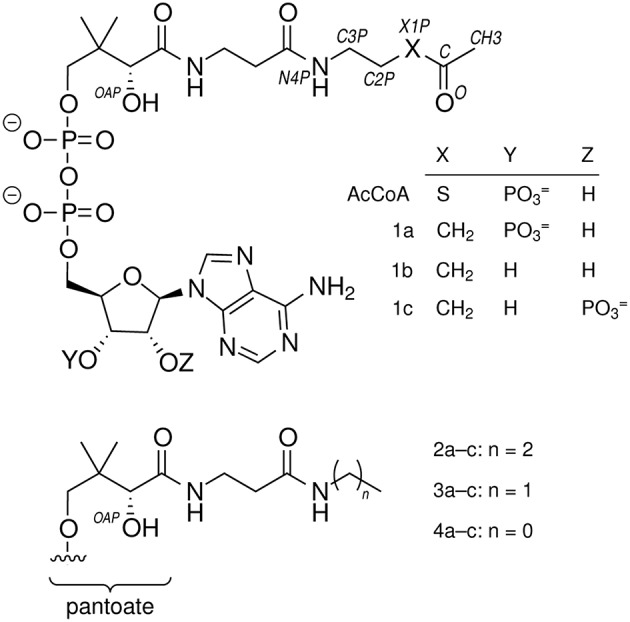
Compounds referred to in this work.